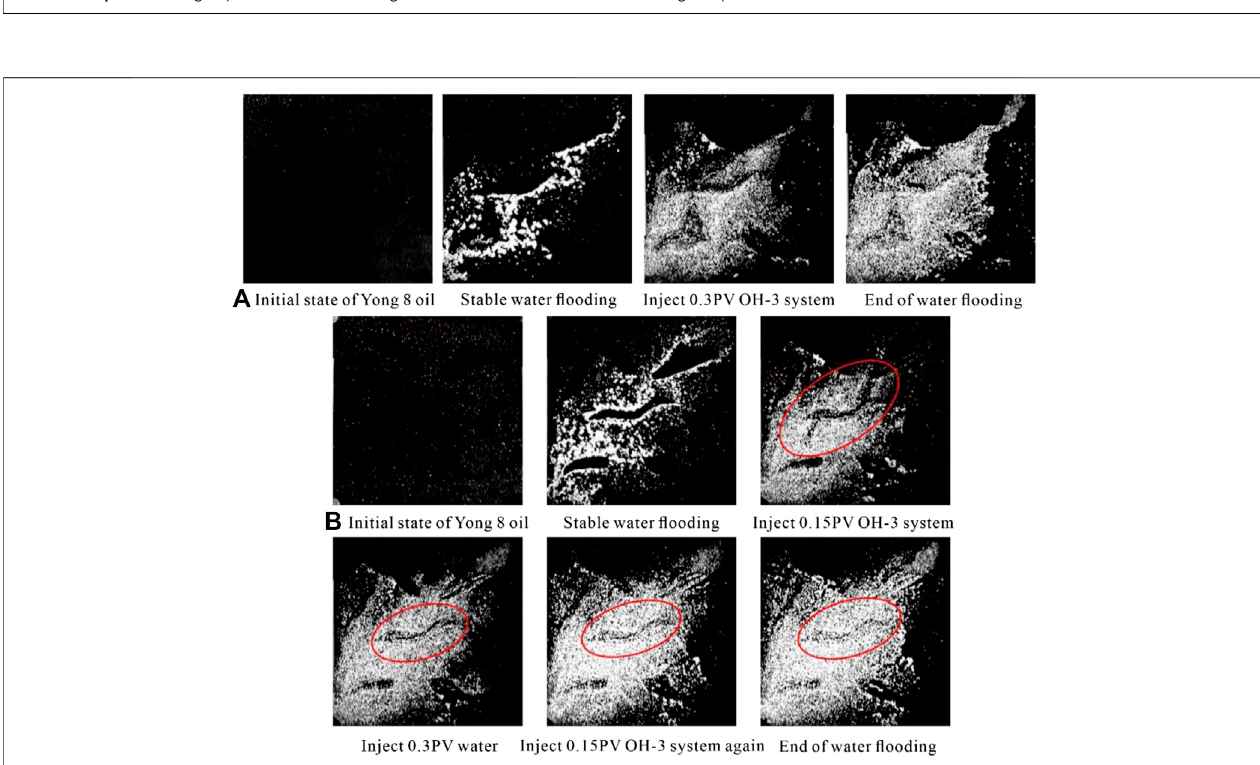
FIGURE 8 | Heterogeneous formation experiment for the visualization glass plate model. (A) Single-slug injection, (B) Dual-slug injection.